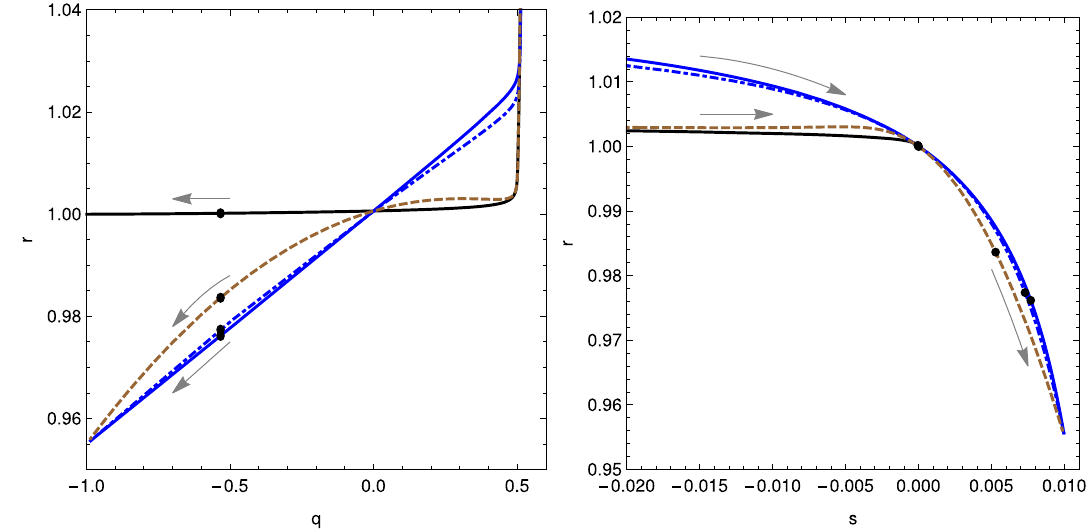
Fig. 12 The figure shows the planes r − q (left) and r − s (right) for the Γ 1 T , Γ 1 d and Γ 1 x models in the case α = 0 . 01. Black dots indi- cate current values and gray arrows the evolution’s direction. The solid